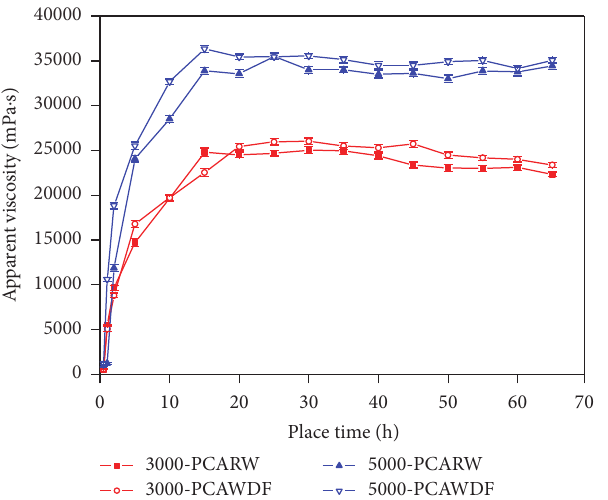
Figure 7: Apparent viscosity versus NaCl concentration curves at 65 ∘ C.